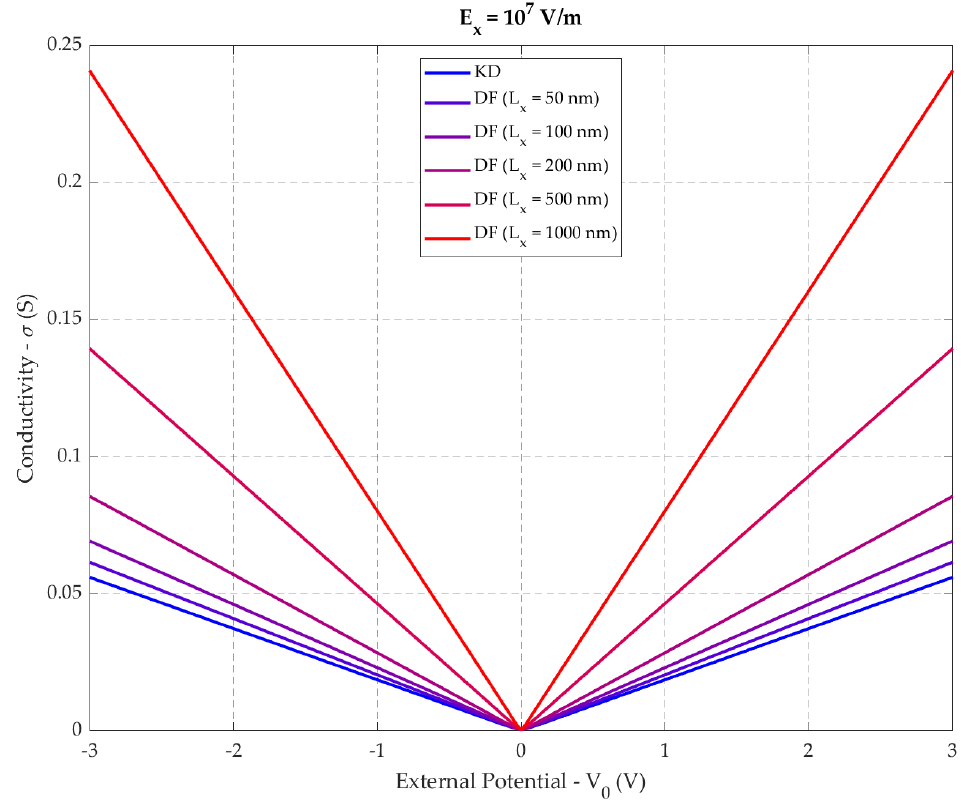
Figure 6. Grapheneconductivity for different values of L x , in the the presence of the longitudinal electric field E = E x ˆx, being V 0 ∈ [ − 3,3 ]